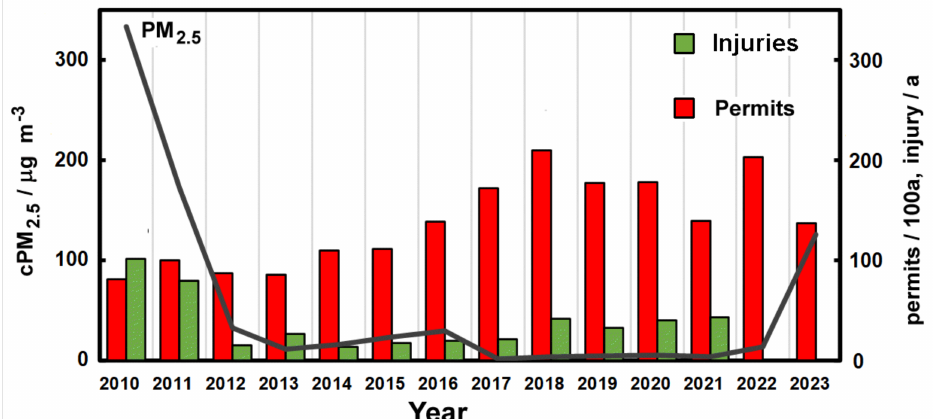
Figure 4. Average PM 2.5 concentrations 21:00 to 02:00 during New Year celebrations as a line. The number of permits (as hundreds) granted prior to New Year (red bars) and the number of injuries at New Year [26]. Note: 2022 and 2023 have no data for injury, and the concentrations are not corrected for weather